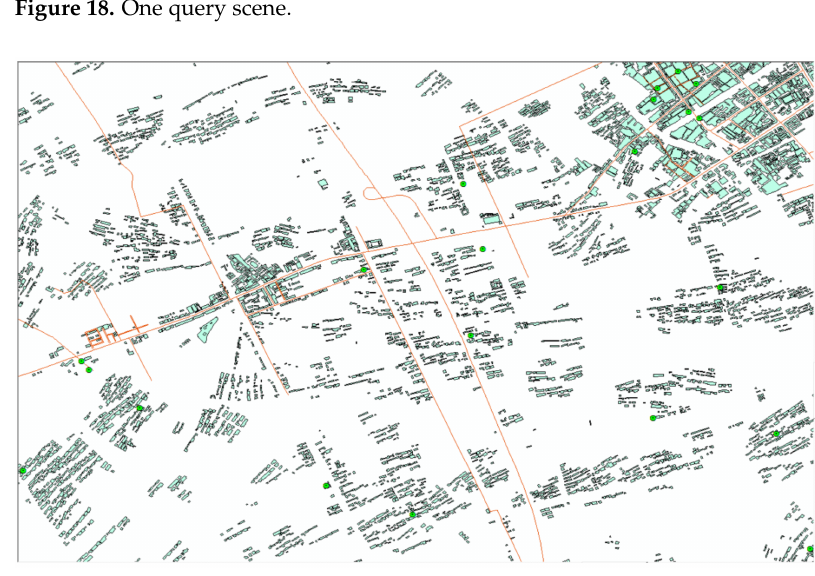
Figure 18. One query scene.